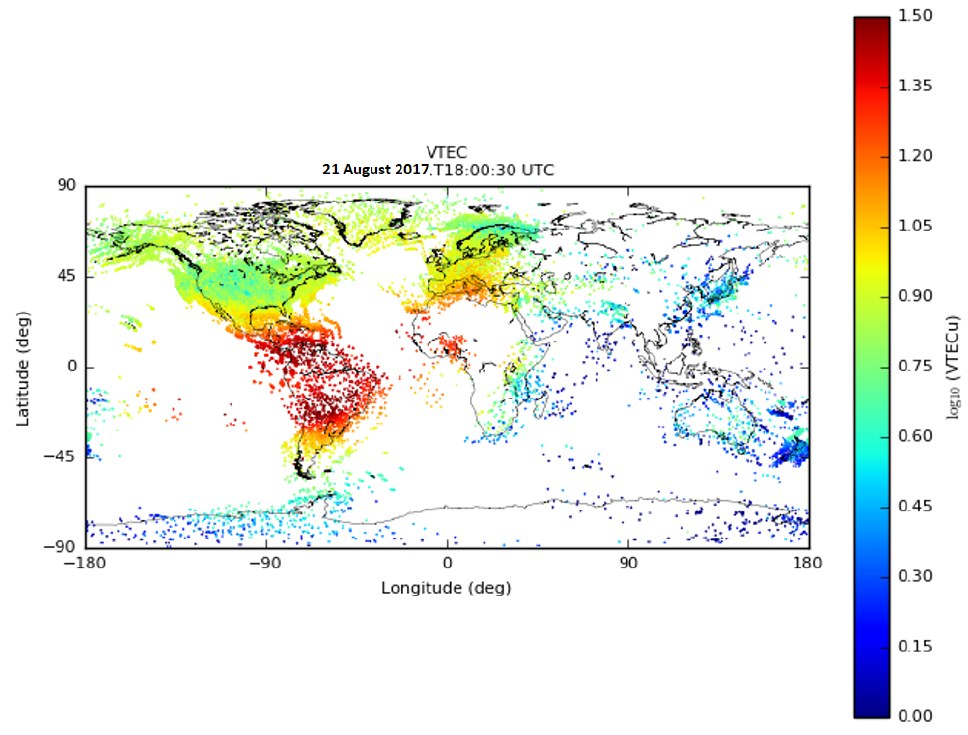
Figure 2. A global VTEC map from MIT Madrigal world-wide GPS receiver network [23]. Other than ionospheric delay, ionospheric irregularities can cause GNSS scintillations (rapid fluctuations in signal’s intensity or/and phase). According to [24], ionospheric irreg- ularities are “small-scale structures in the ionospheric plasma density generally oriented so that the plasma density variations occur rapidly across the geomagnetic field but slowly (or not at all) along the geomagnetic field”. Two ionospheric scintillation indices are used to quantify the scintillation